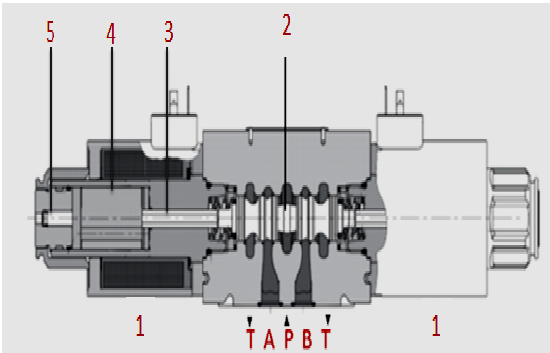
Figure 6 Cross-section of 4/3 solenoid operated direction control valve; (1) solenoids on each side, (2) spool, (3) plunger, (4) core tube, (5) press pin, and ports (T, A, P, and B).